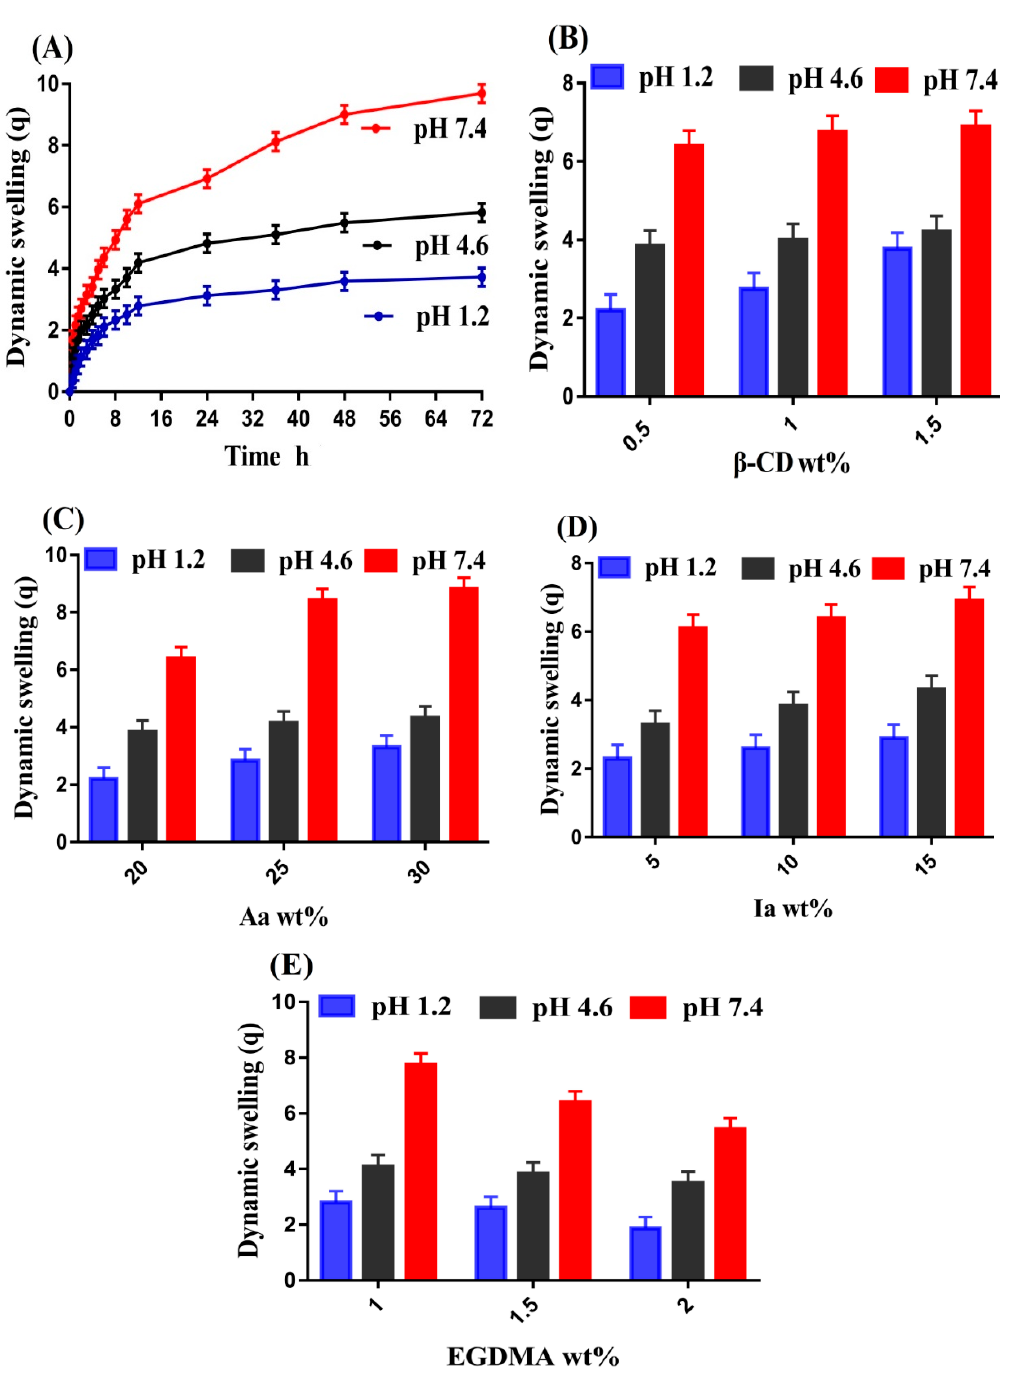
Figure 7. Effect of ( A ) pH, ( B ) β -CD, ( C ) Aa, ( D ) Ia, and ( E ) EGDMA on dynamic swelling of β -CD- g -P(Aa/Ia) hydrogel.